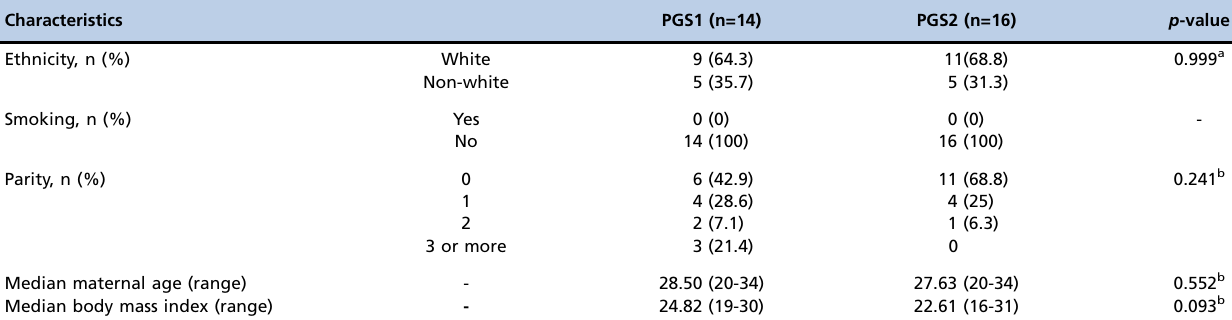
Table 1 - Sociodemographic and clinical characteristics of the study participants in PGS1 and PGS2.